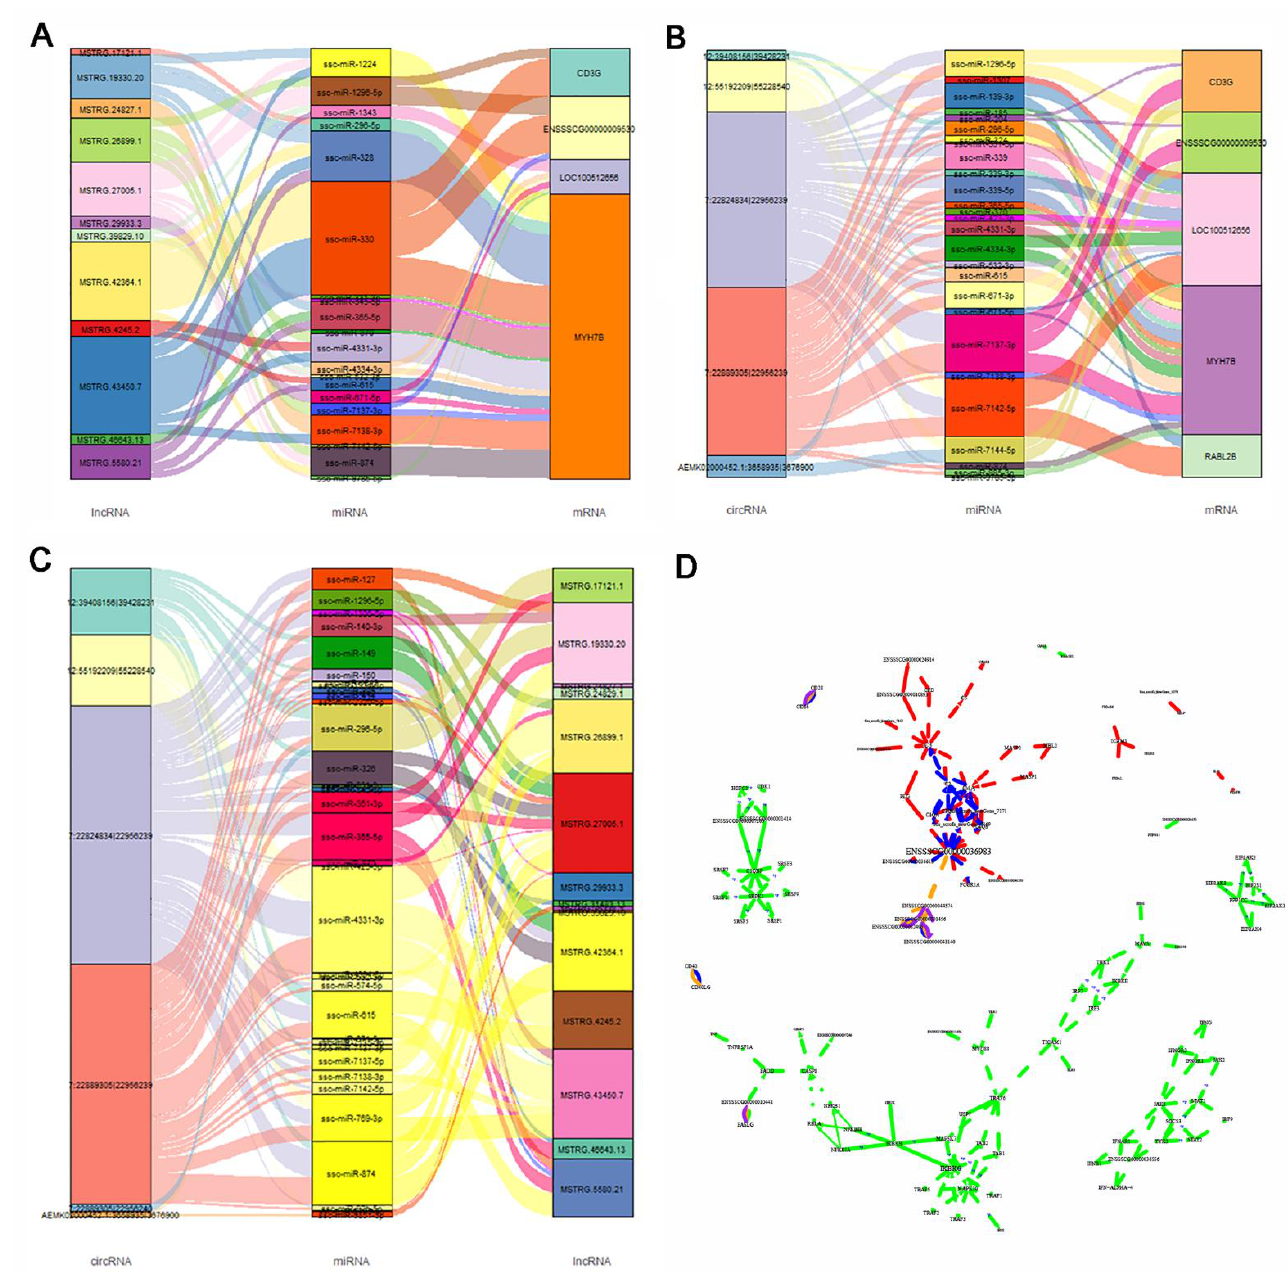
Figure 6. Co-expressed networks of differentially expressed (DE) mRNAs, lncRNAs, and circRNAs, and their targeted miRNAs. ( A ) Co-expressed networks of DE mRNAs and DE lncRNAs with the targeted miRNAs. ( B ) Co-expressed networks of DE mRNAs and DE circRNAs with the targeted miRNAs. ( C ) Co-expression networks of DE lncRNAs and DE circRNAs with the targeted miRNAs. ( D ). The networks of genes in the top five pathways, and the integration analysis of key gene pathways in different ceRNA networks.